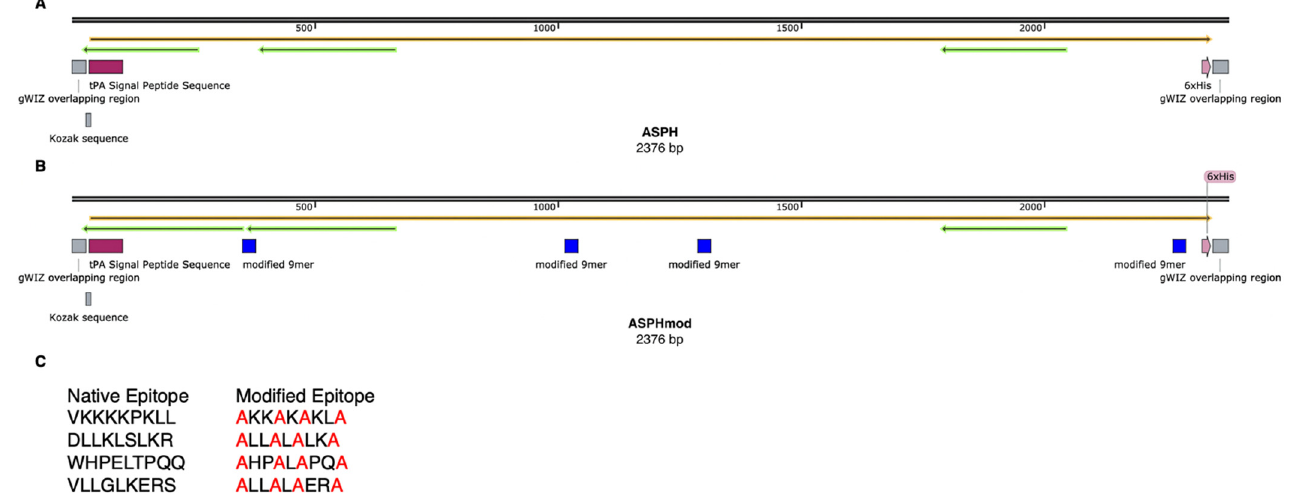
Figure 1. Graphic illustration of ASPH and ASPHmod. ( A ) ASPH and ( B ) ASPHmod are depicted. ( C ) Native 9-mer sequences present in ASPH and modified sequences present in ASPHmod. The illustration was prepared using SnapGene Viewer (Insightful Science; snapgene.com, accessed on 25 April 2022).